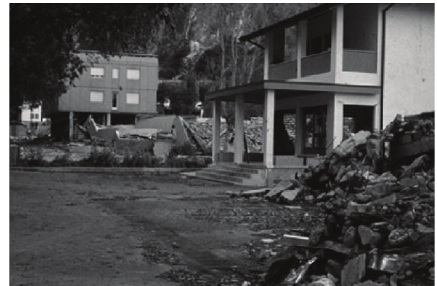
Figure 19: Structural damage caused by the 1976 earthquake in Friuli, Italy (photograph courtesy of Professor H. P. Rossmanith in Vienna).